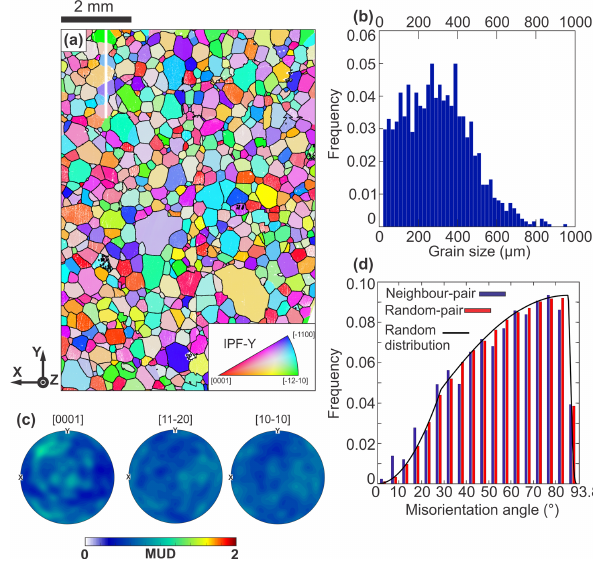
Figure 2. Microstructural details of undeformed standard ice. The EBSD data collected with 5µm step size are presented as (a) orien- tation maps coloured by IPF-Y, which uses the colour map to indi- cate the crystallographic axes that are parallel to the y axis as shown by the black arrows. (b) Grain size distribution. (c) The distributions of orientations for [0001] ( c axes), [11–20] ( a axes) and [10–10] (poles to m planes). (d) Misorientation angle distribution for (a) . Neighbour-pair misorientation angle distribution is shown with blue bars. Random-pair misorientation angle distribution is shown with red bars. Misorientation angle distribution calculated for randomly distributed ice 1h crystals are shown with a black